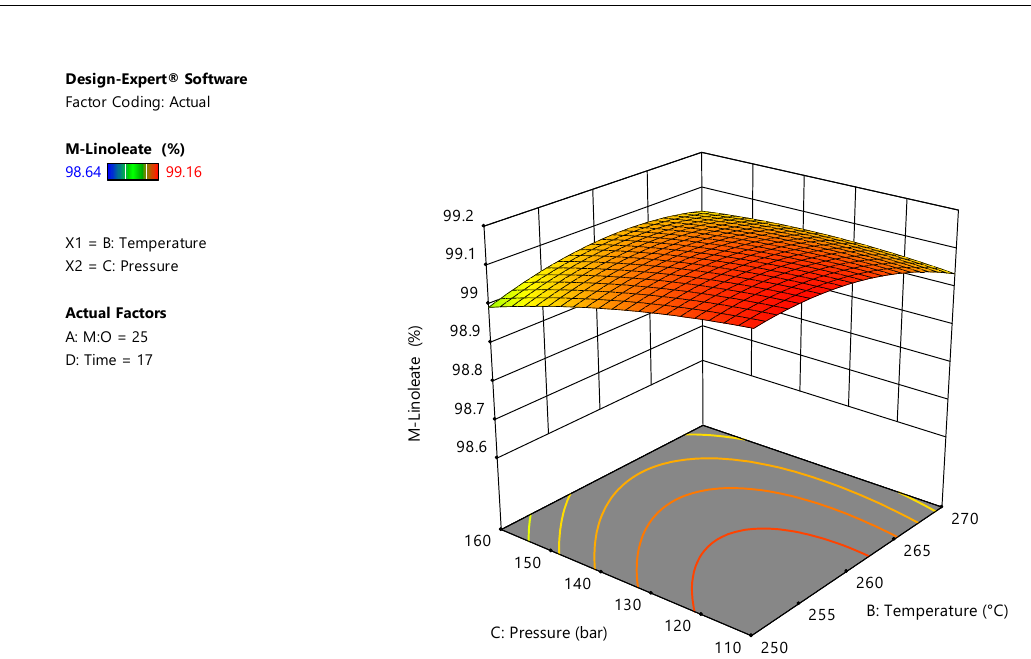
Figure A8. Response surface and contour plot for the effect of reaction temperature and pressure on the yield of methyl-linoleate.